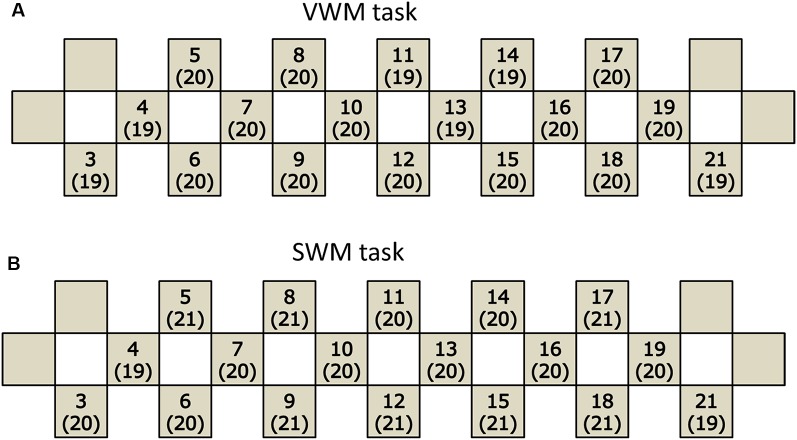
Participants included in the analysis of each task. The number of participants remaining in the final analysis for each channel in the verbal working memory (VWM) task (A) and spatial working memory (SWM) task (B). Each channel is indicated by a square with the channel number and the sample number in parentheses.